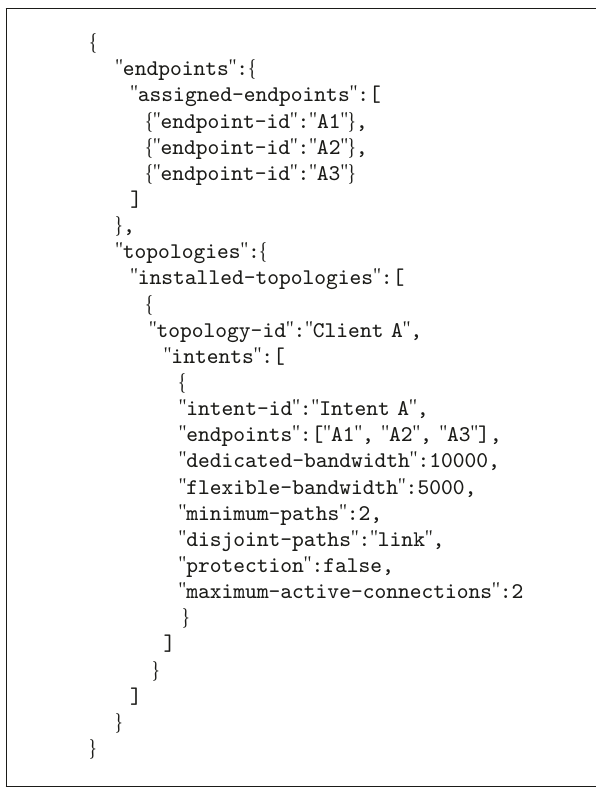
Algorithm 1: JSON representation of an example for a virtual topology configuration for client A corresponding to the depicted virtual topology in Figure 3.